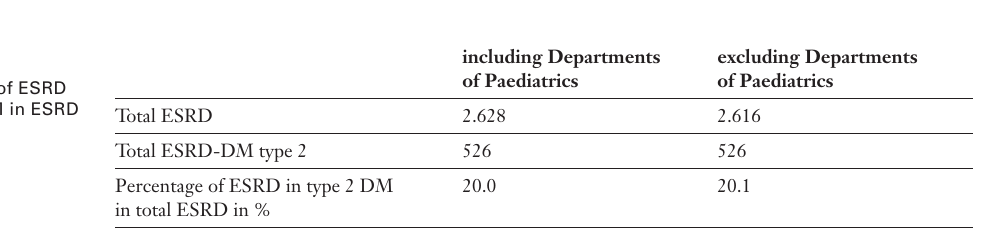
Costs resulting in 2001 from transplan- tations performed in 2001.